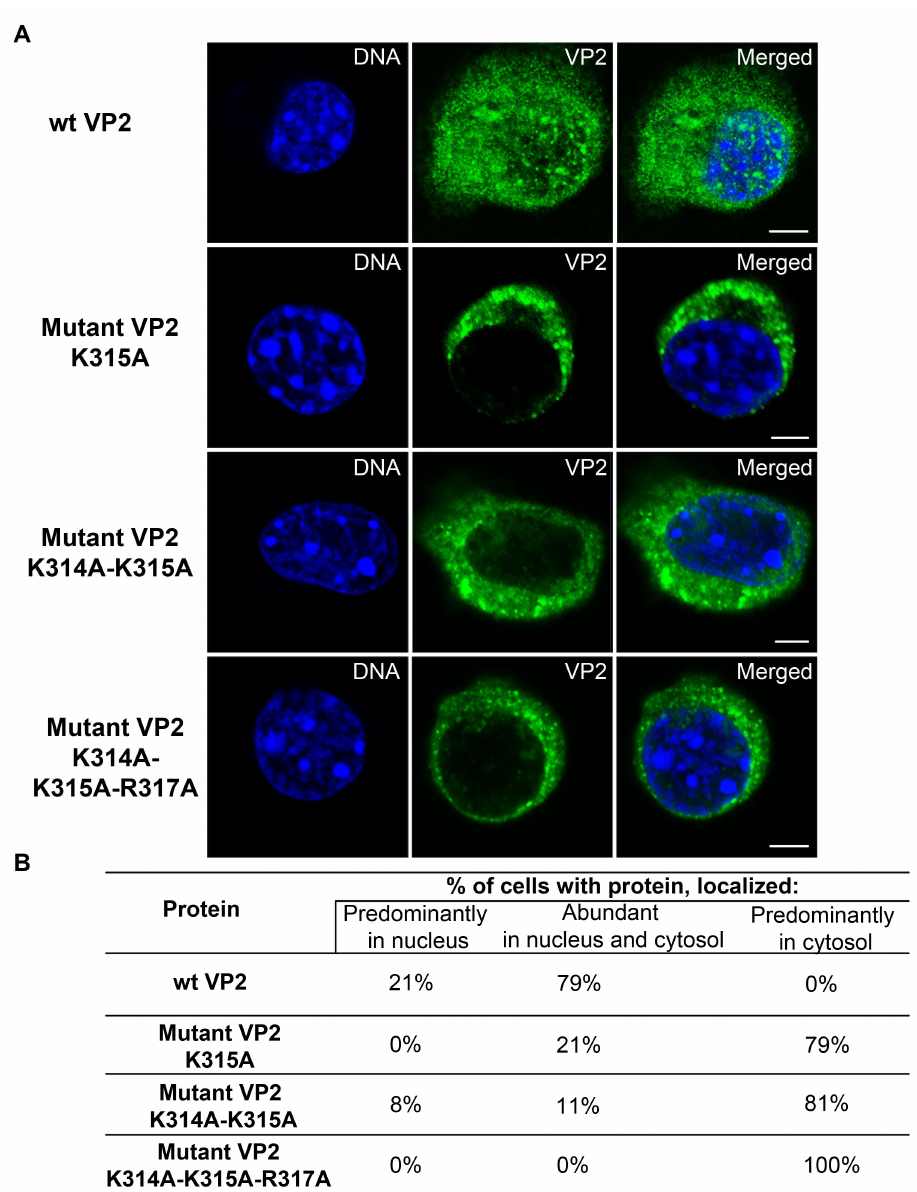
Figure 8. Subcellular localization of wild type or mutated VP2 proteins. Confocal sections of 3T3 cells expressing wt or mutated VP2 proteins. Cells were fixed at 5 hpt and stained by antibodies against VP2 (green) and DNA by DAPI (blue). Bars 5 µ m ( A ); Scores are given as percentage ( B